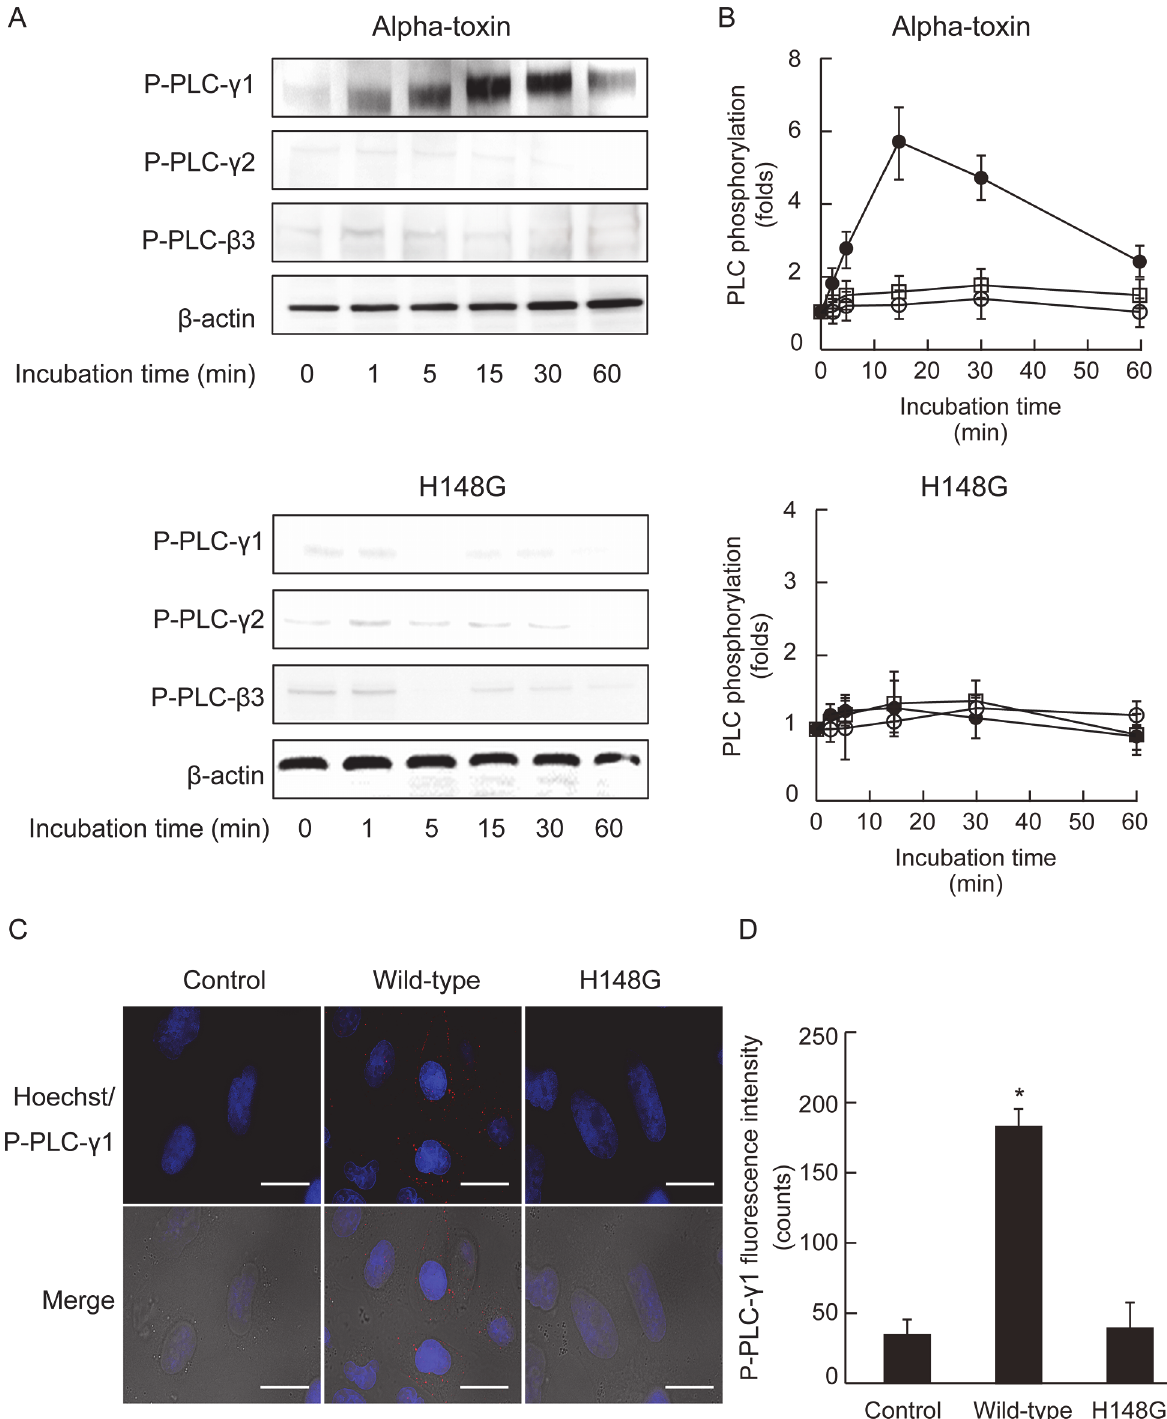
Fig 6. Alpha-toxin stimulated the phosphorylation of phospholipase C γ -1. (A) A549 cells were incubated with 1.0 μ g/mL wild-type alpha-toxin or 1.0 μ g/mL H148G alpha-toxin at 37°C. Cell lysates were separated by SDS-PAGE and blotted with antibodies to phospho-PLC γ -1, phospho-PLC γ -2, and phospho-PLC β - 3. (B) Phosphorylated of PLC γ -1 (black circles), PLC γ -2 (white circles), and PLC β -3 (white squares) in untreated cells was set to 1. Values represent the mean ± SE; n = 5. (C) A549 cells were incubated with 1.0 μ g/mL wild-type or H148G alpha-toxin at 37°C for 60 min. The cells were fixed, permeabilized, and stained with phospho-PLC γ -1 antibody and Hoechst 33342. Phospho-PLC γ -1 (red) and nuclei (blue) were visualized by fluorescence microscopy. Scale bar, 10 μ m. (D) Phospho- PLC γ -1 fluorescence intensity was measured as described in Materials and Methods. Values represent the mean ± SE; n = 5; * , p < 0.01.